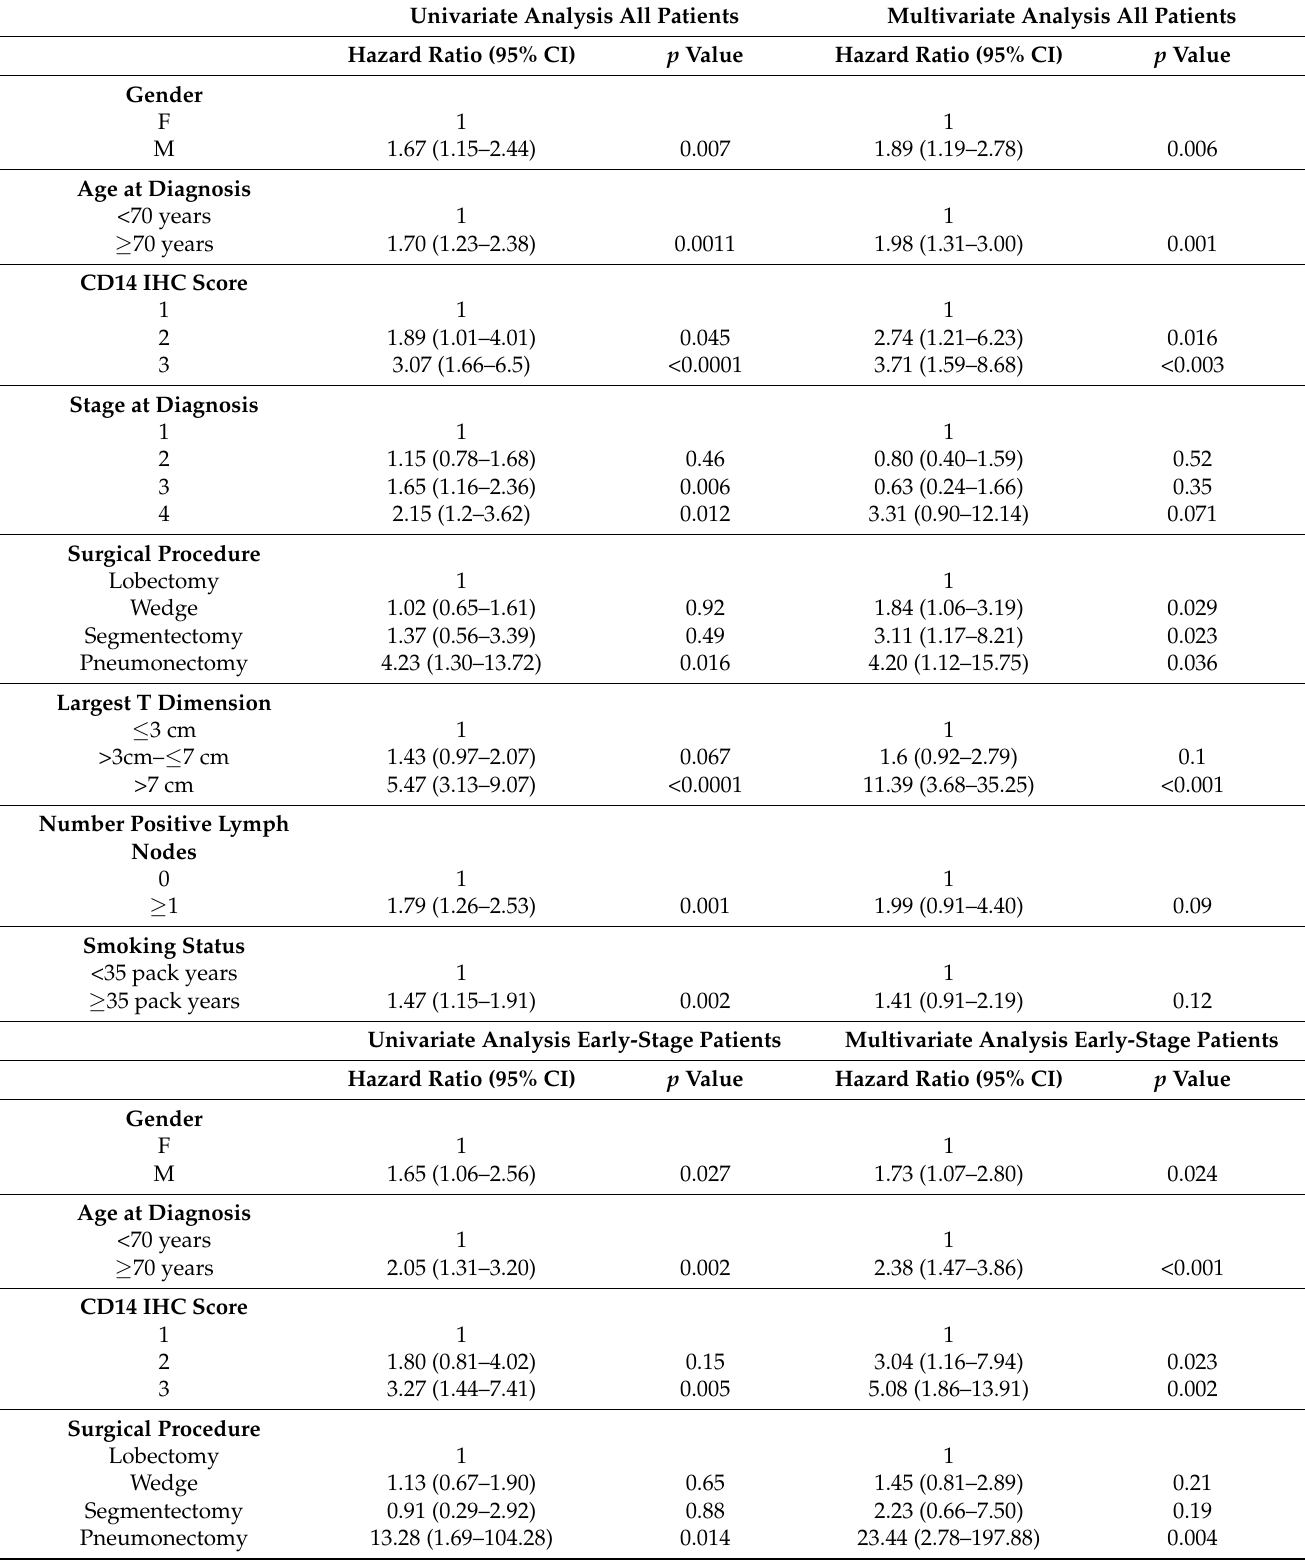
Table 2. Univariate and Multivariate Analysis for Patient Overall Survival. Univariate Analysis All